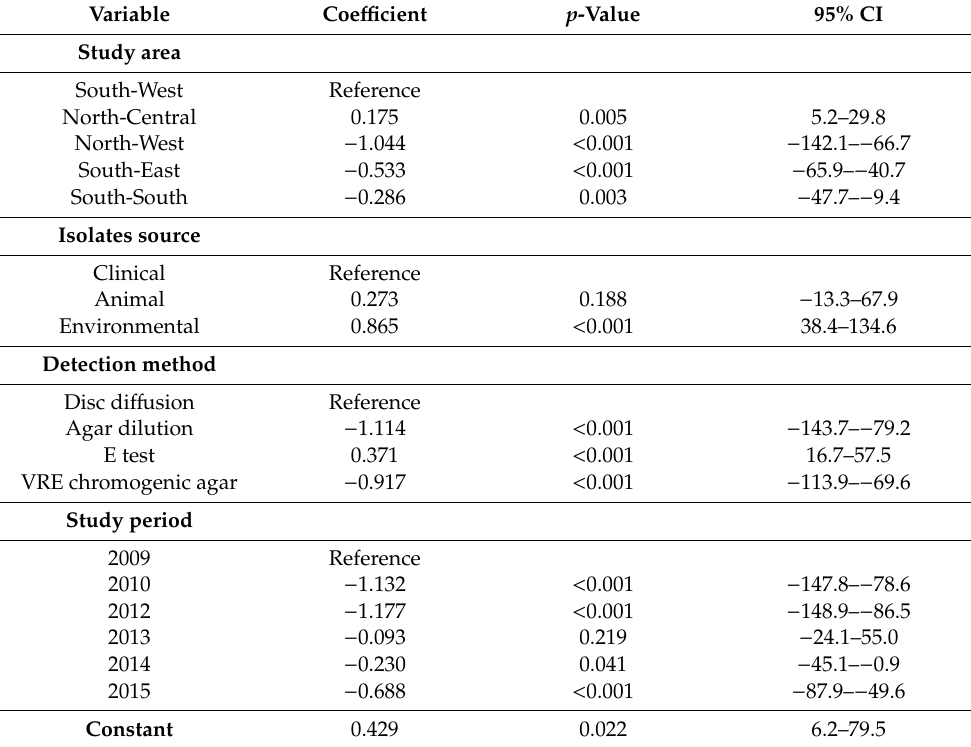
Table 7. Final multivariable meta-regression